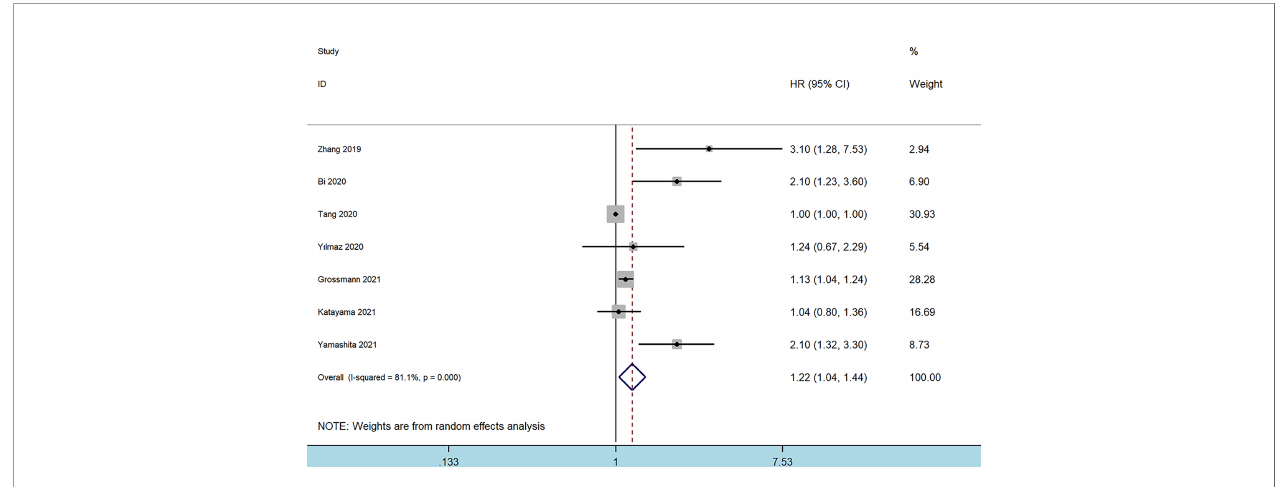
FIGURE 2 | Forest plot of the association between systemic immune-in fl ammation index and overall survival in patients with bladder